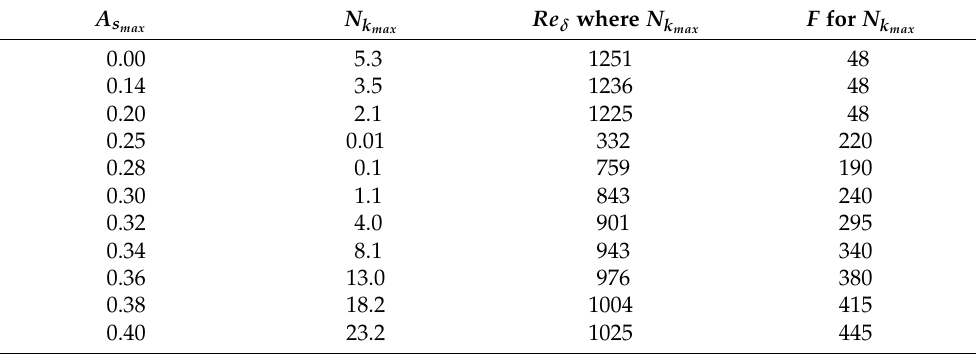
Table 1. Maximum N -factor for each streak simulated, providing streamwise location R δ and frequency F of the